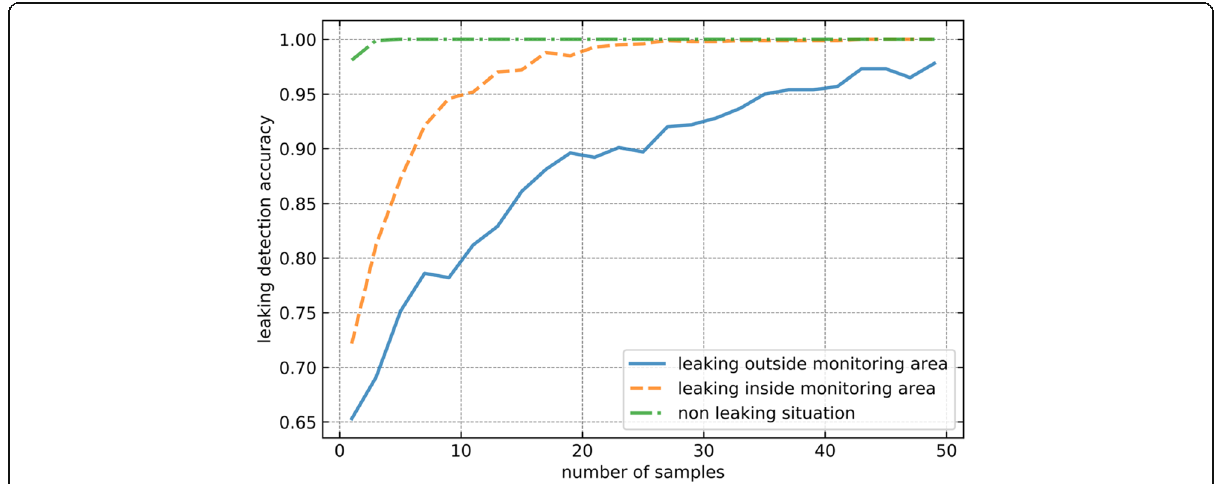
Fig. 14 Accuracy of correct pipe condition detection with multiple attempts with pre-trained AE model with threshold set as 0.000402